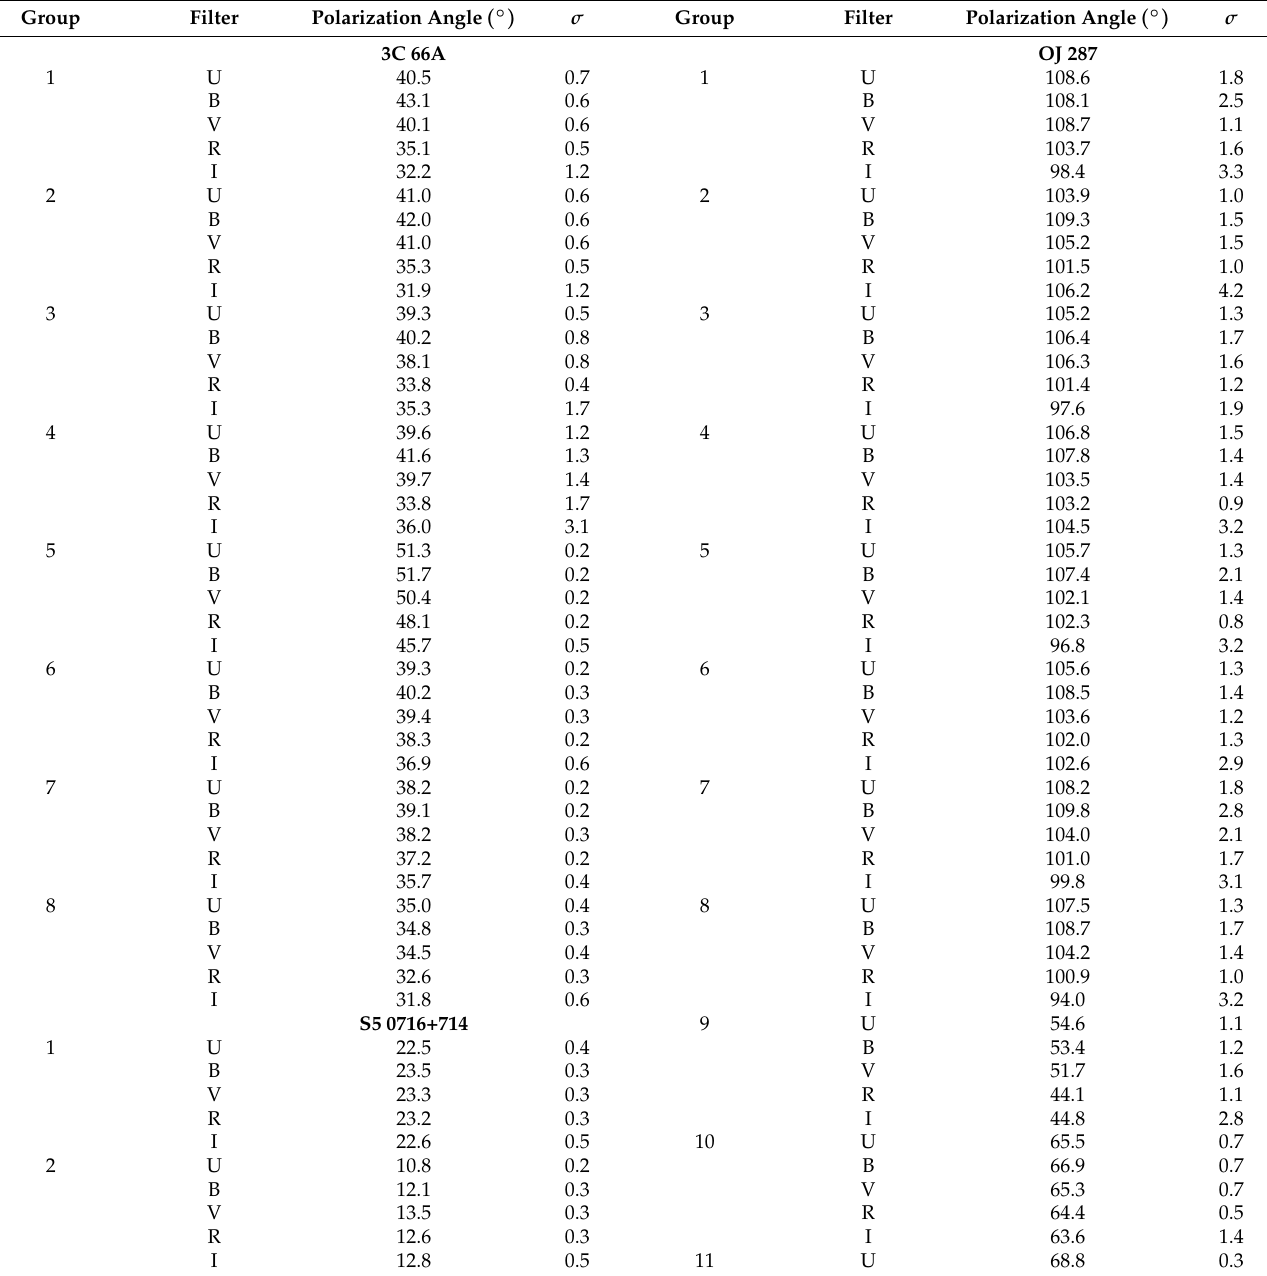
Table 1. Measurements of multiwavelength polarization for different